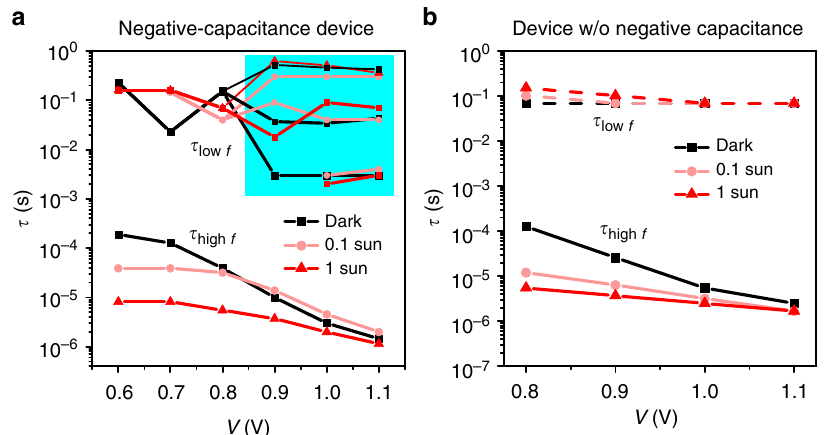
Fig. 3 Time constants extracted from EIS data for different light intensities. a Negative-capacitance device. The capacitance changes sign at 0.8 V and the shaded area describes negative values, where the impedance data were fi tted with multiple time constants. Details in Supplementary Table 1. b Device without negative capacitance. In both cases, the τ low f remains independent of voltage and illumination at around 0.1 s. The data were extracted from the EIS data shown in Fig. as seen in the plot of the real part of the impedance in Fig. 2c, d.